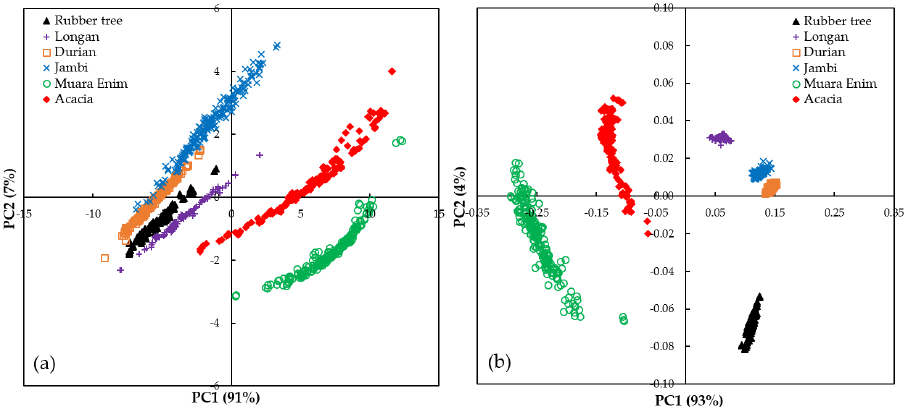
Figure 3. The score plot of the first two PCs (principal components; PC1 × PC2) for both the original ( a ) and pre-processed spectra ( b ) between 250–400 nm for the six different types of honey collected.